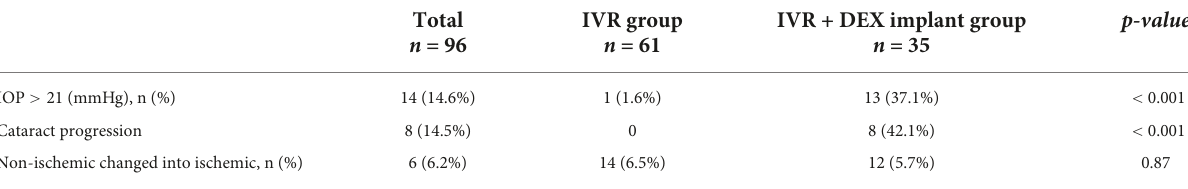
TABLE 3 Adverse effects and other ocular procedures during the study